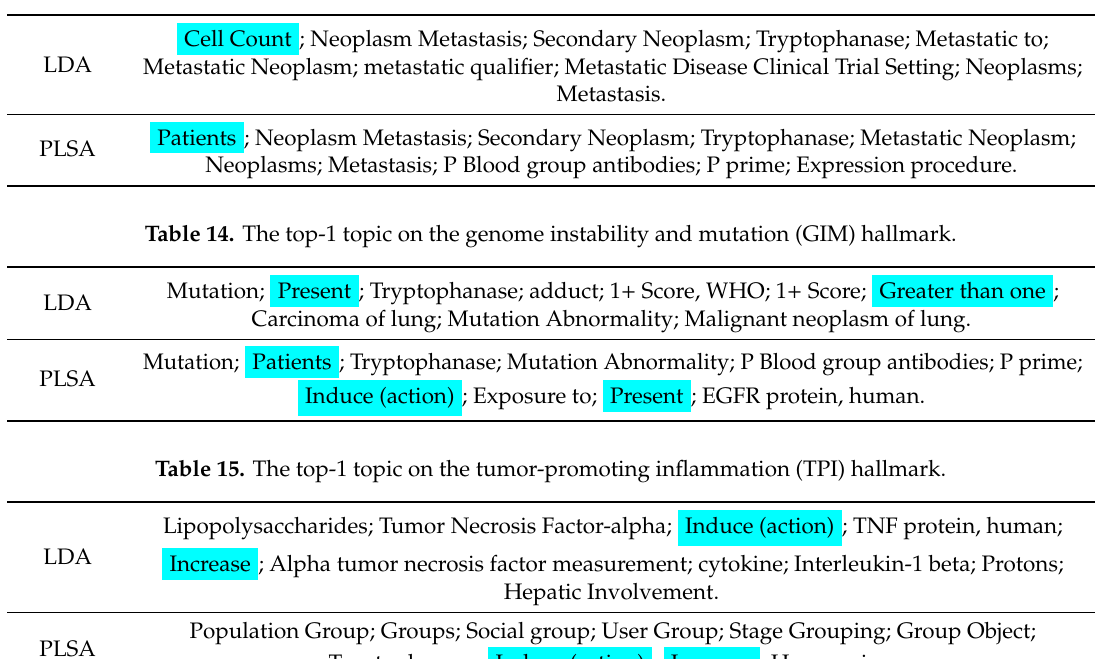
Table 13. The top-1 topic on the activating invasion and metastasis (AIM) hallmark.